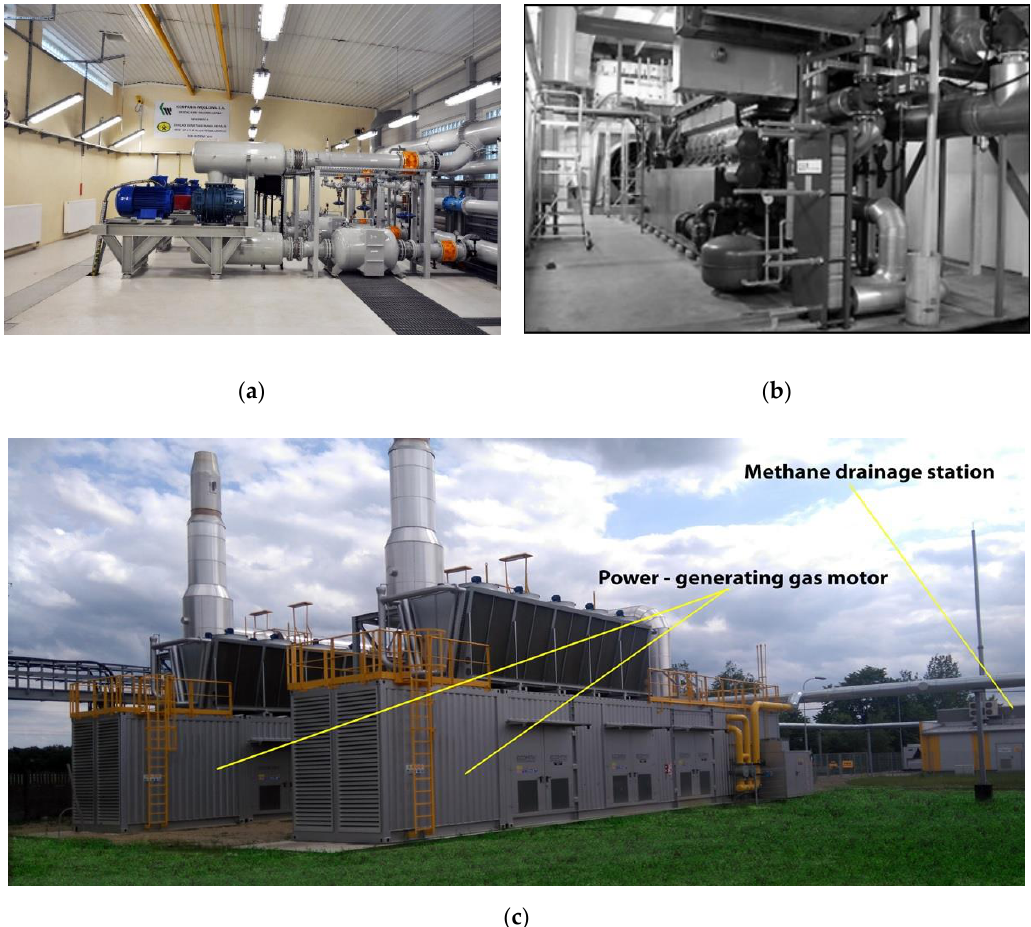
Figure 6. Methane drainage system installation ( a ) Roots-type blower; ( b ) combined power and cooling system installation located in the Pniówek coal mine [25]; ( c ) Drainage station with a cogeneration system of power and heat generation.